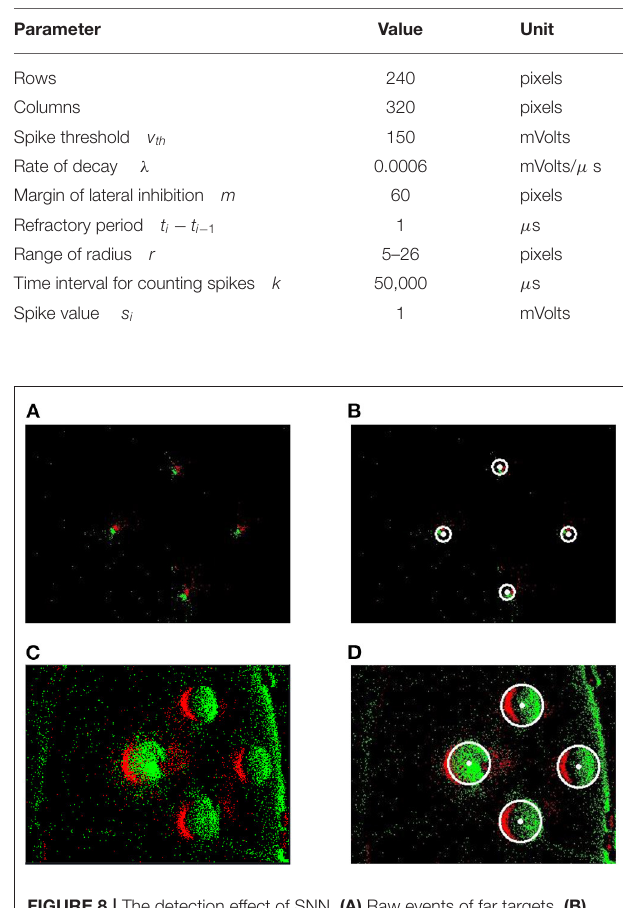
FIGURE 7 | Results of frame-based GHT. (A) Raw event frame. (B) Effect of detection.